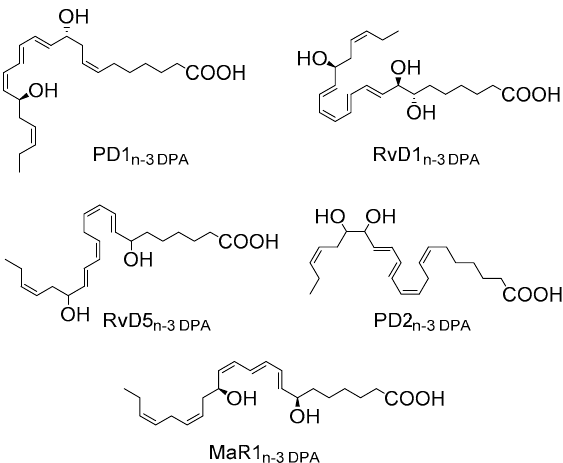
Figure 2. Chemical structures of some n-3 DPA derived SPMs. Where known, the absolute configuration is